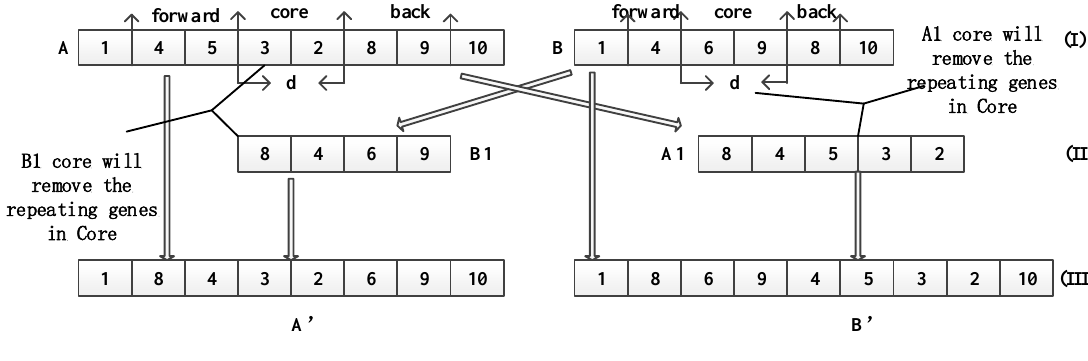
Figure 10. Crossover